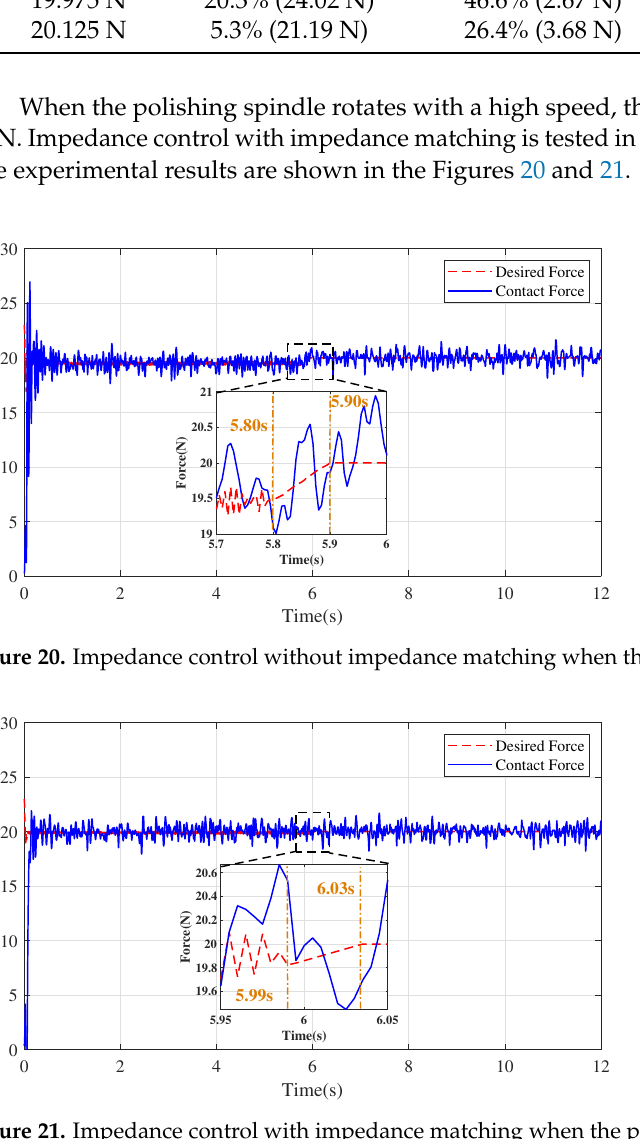
Figure 21. Impedance control with impedance matching when the polishing spindle rotates. Compared with the direct force control in Figure 14a, Figure 20 shows the maximum overshoot of contact force reduces to 38.2% (26.97 N) according to the impedance con- troller’s output force and desired force (19.51 N). The parameters of impedance controller change to zero from 5.80 s to 5.90 s. When impedance matching is introduced in the macro- mini manipulator, the sum of the reference force and desired force is 19.88 N. Figure 21 shows the force’s maximum overshoot further reduces to 10.3% (21.92 N). Due to the polishing tool being eccentric to the center of the spindle, the contact point will vibrate while rotating. The force precision is ± 2 N. When the contact force reaches steady state, its Fourier transform is shown in Figure 22. Compared with the amplitude in Figure 11, it increases because of the spindle’s rotation. After introducing the impedance matching, the amplitude of the contact force’s amplitude decreases at steady